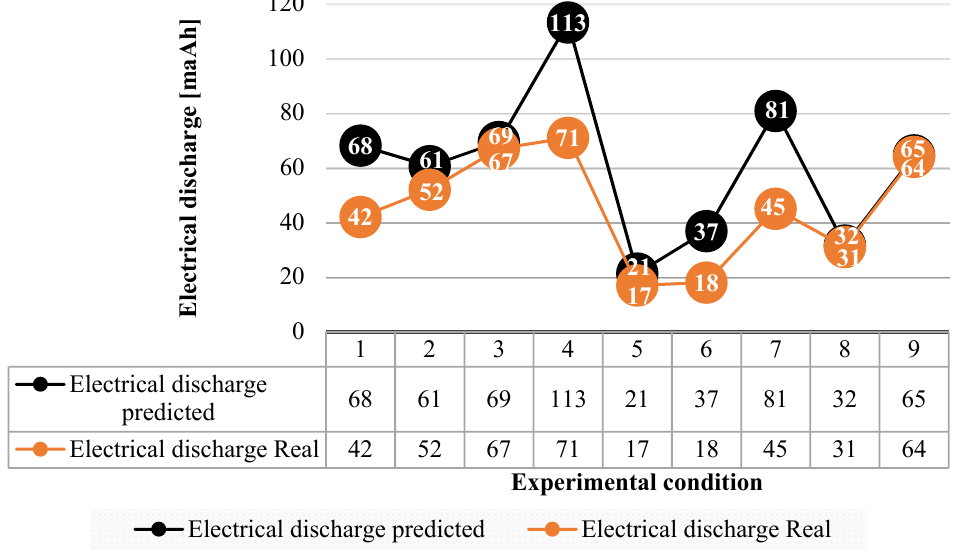
Figure 16. Comparison of predicted electrical discharge versus observed electrical discharge.